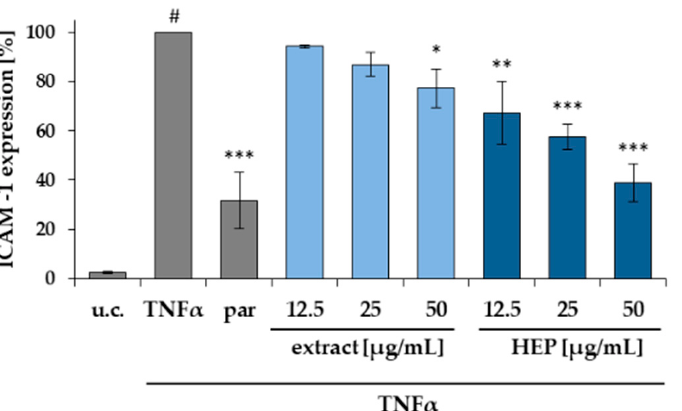
Figure 8. Influence of the ethanolic extract and the n-heptane fraction (HEP) on ICAM-1 expression in HMEC-1 cells. The test was performed with pure medium (u.c.), with TNF α (10 ng/mL) and parthenolide + TNF α (par, 5 µ M) as positive control. Substance concentrations between 12.5–50 µ g/mL were applied. Data are presented as mean ± SD; # p < 0.001 vs. u.c.; * p < 0.05, ** p < 0.01, *** p < 0.001 vs. TNF α ( n =